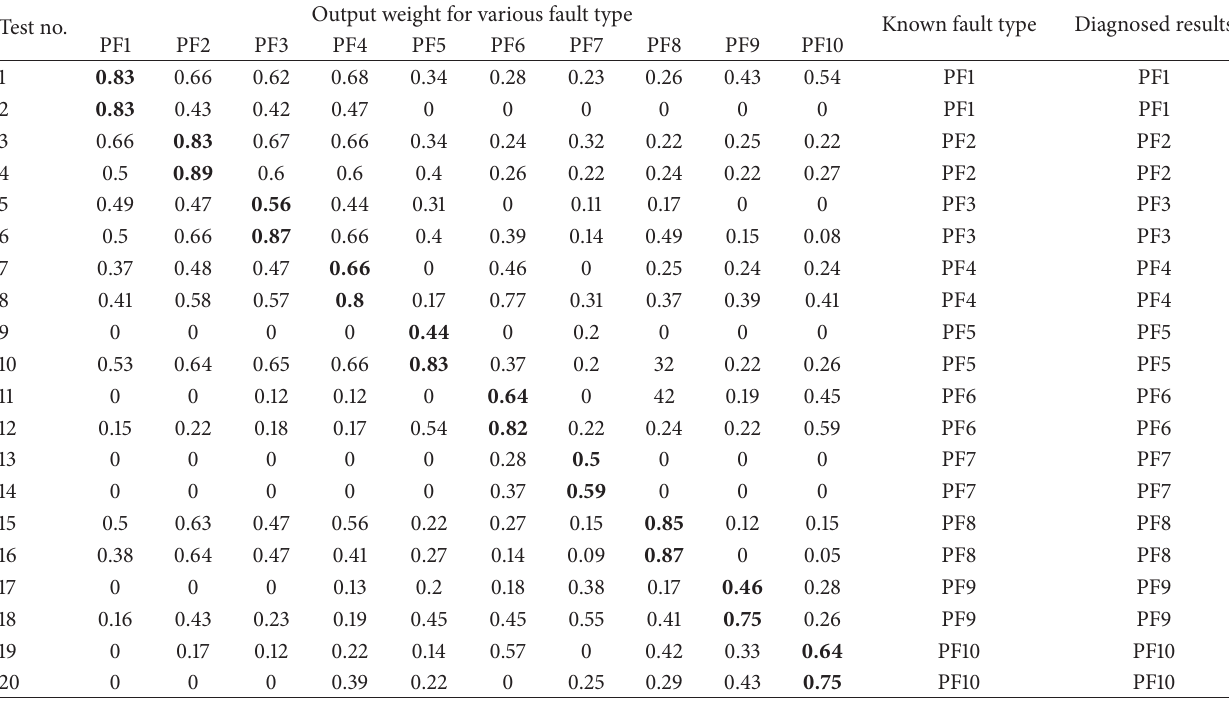
Table 11: Diagnosis results of the test data with additional errors and under 300–1000W/m 2 irradiation and PV module surface temperatures between 51 and 60 ∘